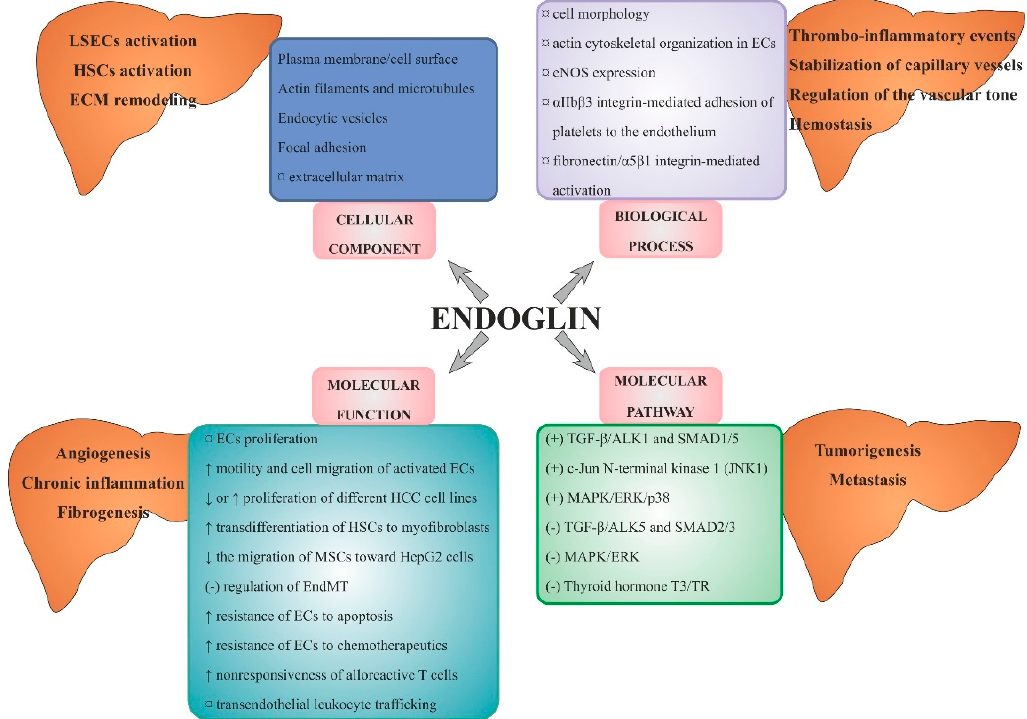
Figure 2. Summary of the roles and signalling pathways of endoglin in HCC angiogenesis and